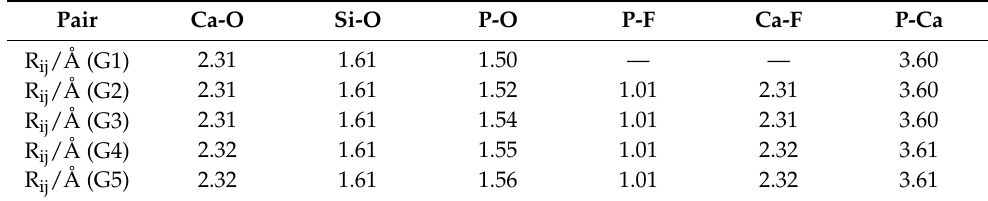
Figure 2. ( a ) RDF and ( b ) CN for different atom pairs in CaO-SiO 2 -CaF 2 -P 2 O 5 systems and changes of P-O and Si-O coordination numbers: ( c ) Si-O and ( d ) P-O. Table 4. Variation of average bond lengths of different atom